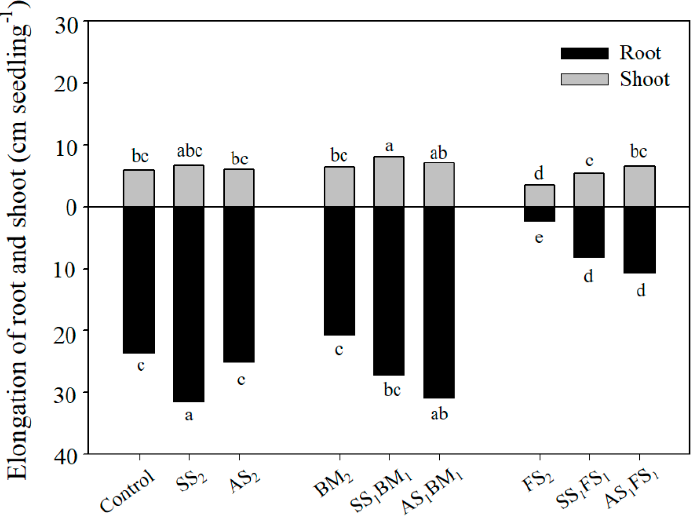
Figure 2. Root and shoot elongation of bok choy ( Brassica campestris L. ssp. chinensis Jusl.) cultivated for 3 weeks in soil treated with various combinations of amendments. Different letters indicate significant differences at the 5% level by Duncan’s test. The treatment combinations are indicated in Table 1; SS 2 , steel slag (SS) 2%; AS 2 , acid mine drainage sludge 2%; BM 2 , bone meal (BM) 2%, FS 2 , fused superphosphate (FS) 2%; SS 1 BM 1 , SS 1% + BM 1%; SS 1 FS 1 , SS 1% + FS 1%; AS 1 BM 1 , AMDS 1% + BM 1%; and AS 1 FS 1 , AMDS 1% + FS 1%.